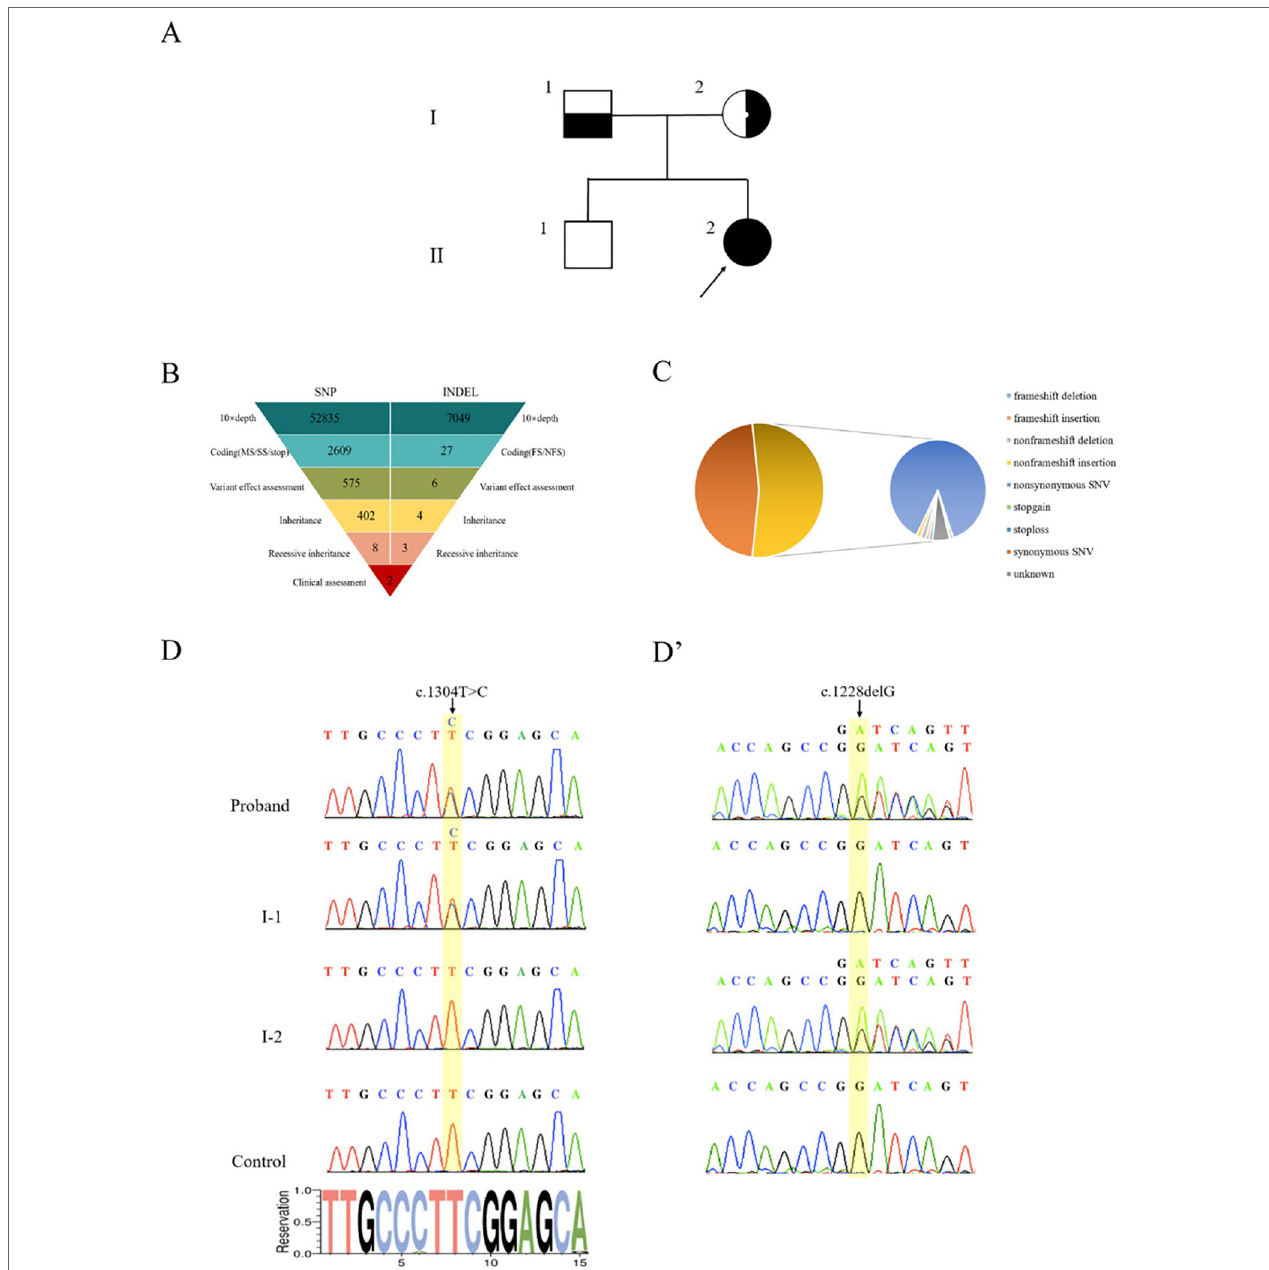
FigURe 2 | Genetic diagnosis. (A) The pedigree with 17α-hydroxylase/17,20-lyase deficiency. The arrowhead denotes the proband. (B) Schematic representation of the exome-data-filtering approach under the assumption of recessive inheritance in the family. The following abbreviations are used: MS, missense variant; SS, splice-site variant; stop, stop-codon variant; FS, frameshift indel; and NFS, non-frameshift indel. (C) Percentage of variants in exome regions. (D) Sanger sequencing chromatograms showing that the proband and her father (I-1) harbor a heterozygous c.1304T > C variant of the CYP17A1 gene. (D’) Sanger sequencing chromatograms showing that the proband and her mother (I-2) harbor a heterozygous c.1228delG deletion of the CYP17A1 gene.